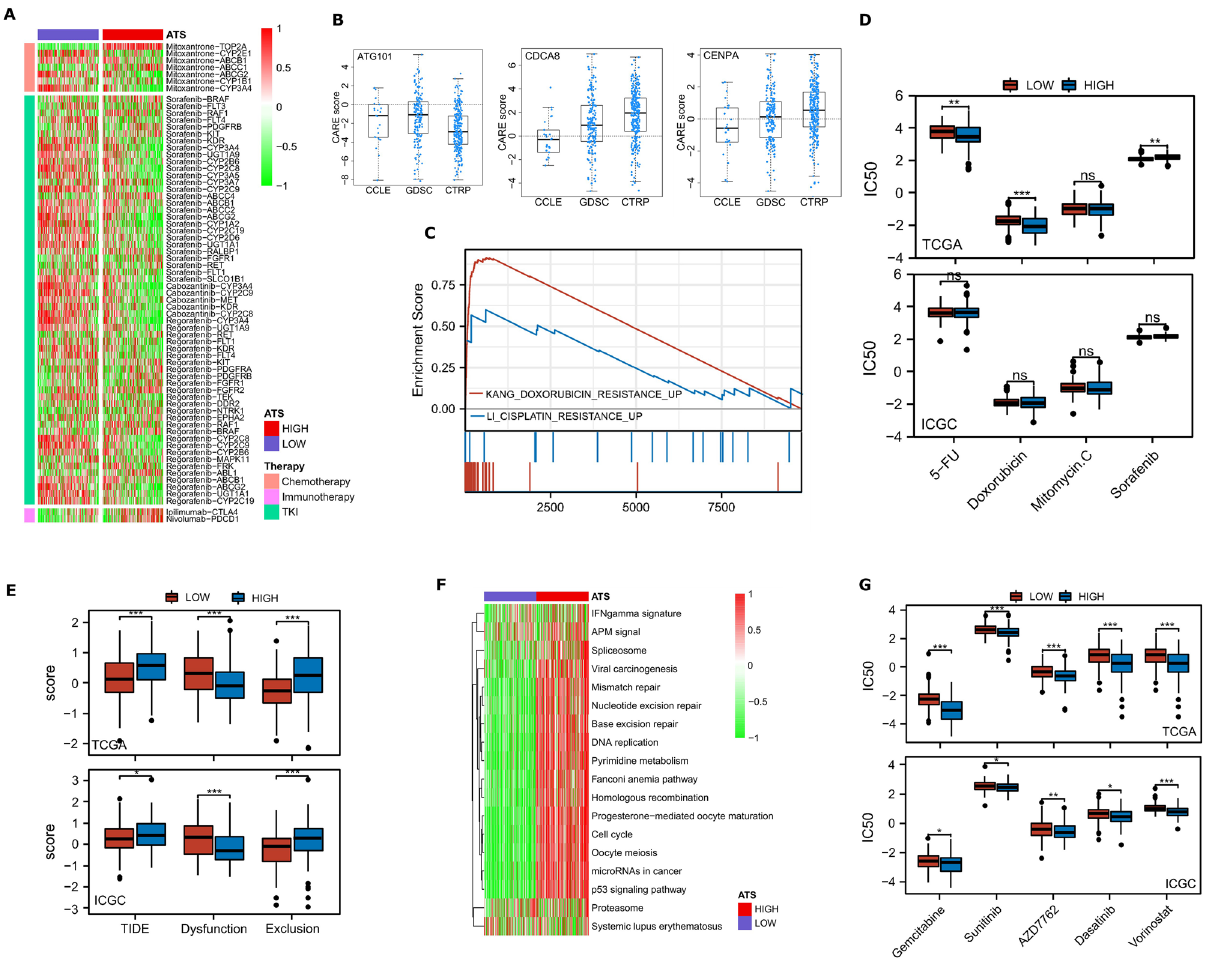
as assessed by CARE. ( C ) GSEA predicted an association between the gene signature and treatment resistance. ( D ) The connections between IC50 values of commonly used anti-HCC compounds and ATS state. ( E ) The ICB response calculated using TIDE algorithm. ( F ) Differences in immunotherapy-predicted pathway enrichment scores between high- and low-ATS groups. ( G ) Chemotherapy sensitivity differences between high-risk